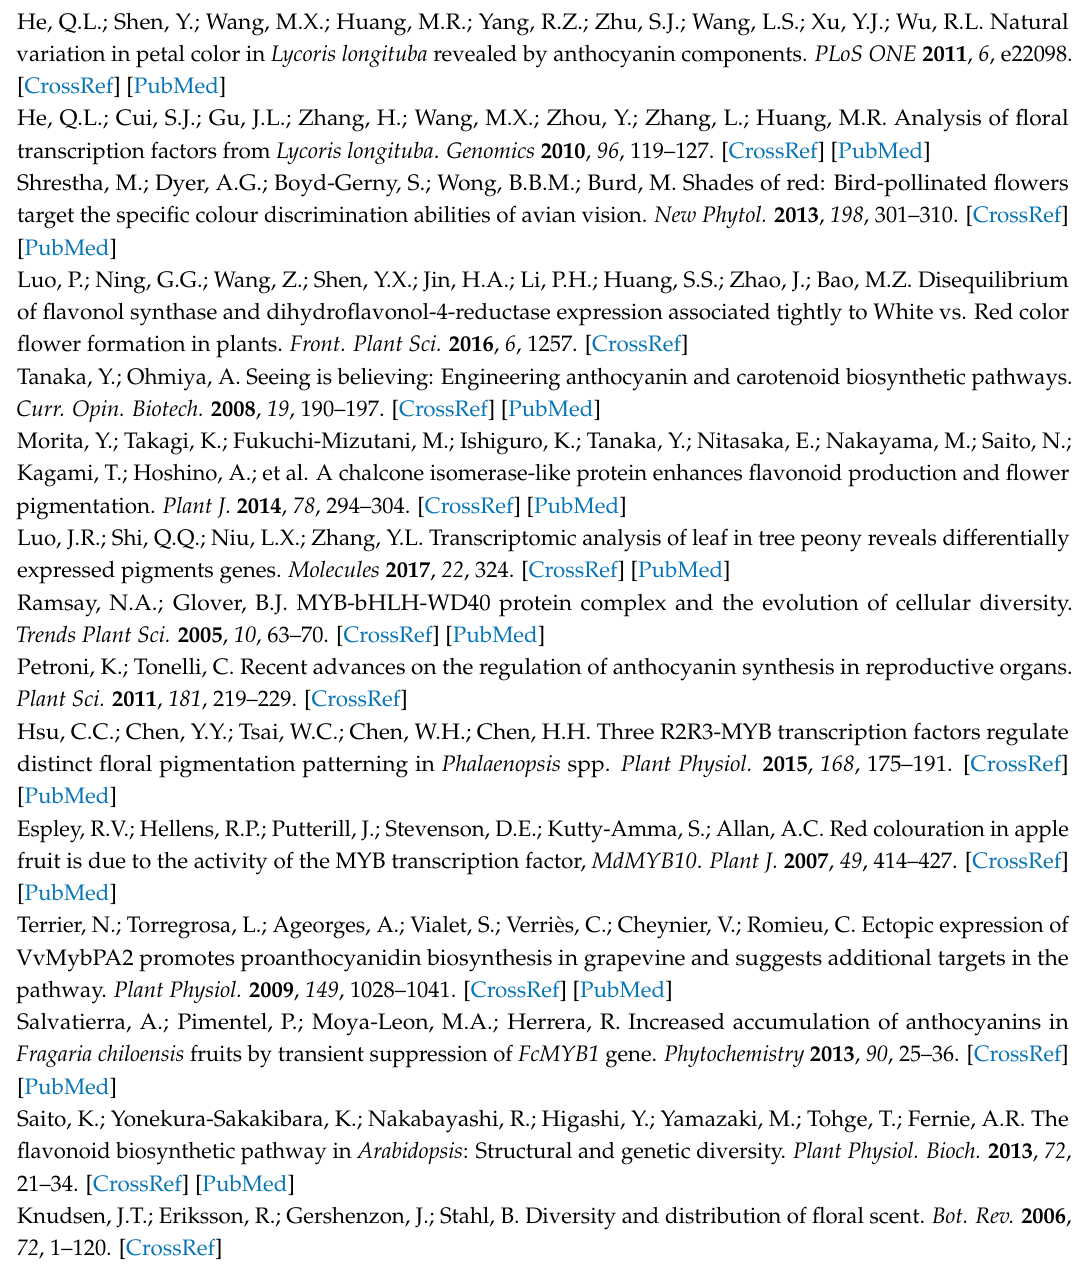
Figure S1: GO classification of DEGs among different samples in L. longituba , Figure S2: The KEGG enrichment of DEGs among the different samples, Table S1: Species distribution of the BLAST hits for all homologous sequences, Table S2: Primers used for